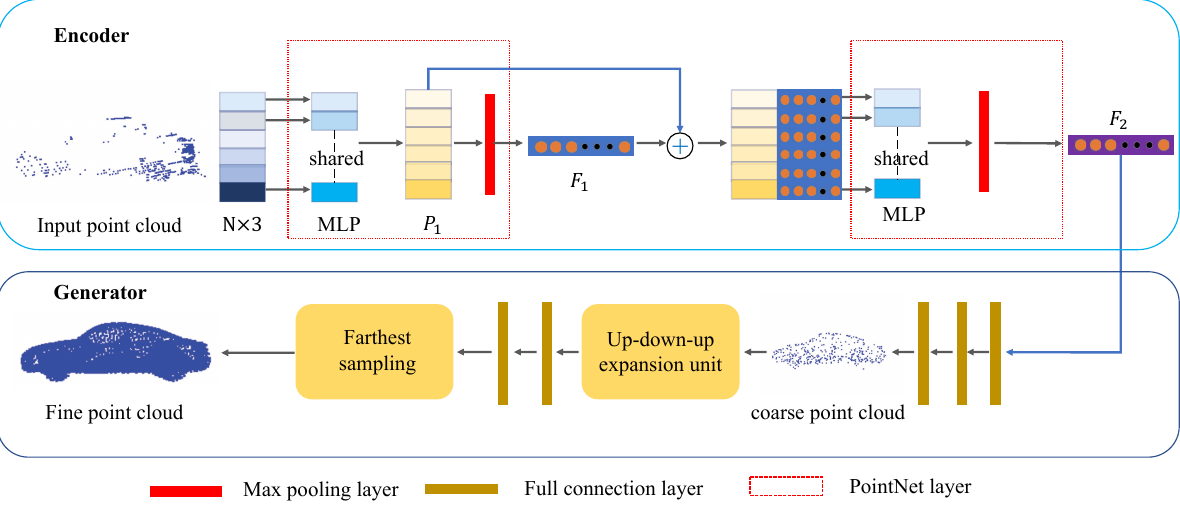
Figure 2. A pipeline of the proposed S2U-Net, in which the global feature is extracted by an encoder network. Then, a coarse-to-fine strategy is applied for the following